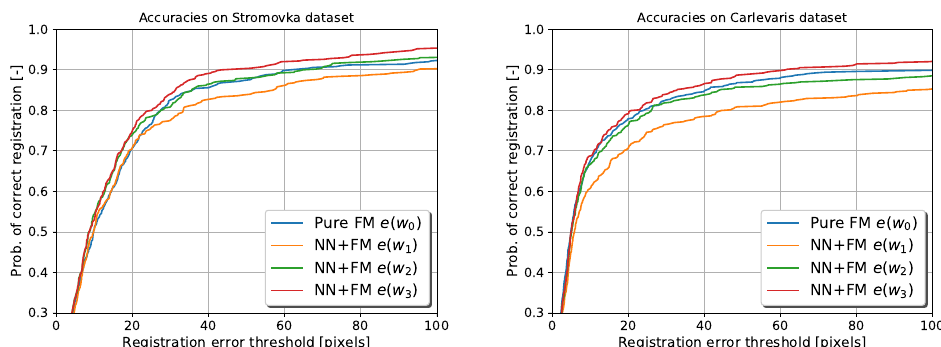
Figure 8. Probabilities of correct image registration when using the Nordland-trained network on Stromovka dataset ( left ) and Carlevaris dataset ( right ).